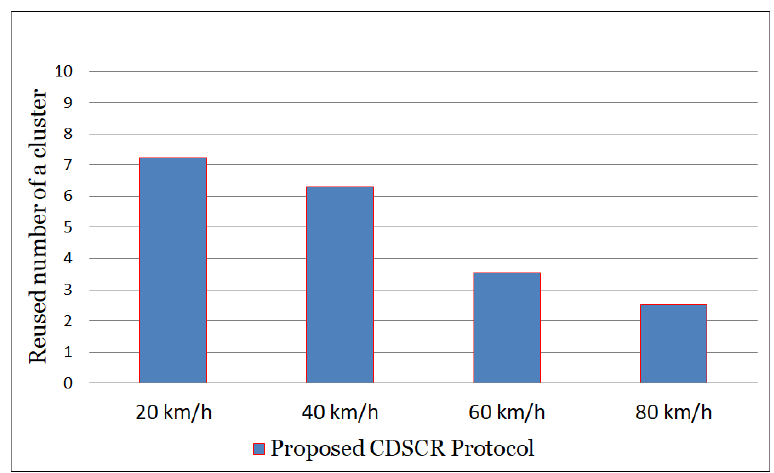
Figure 8. Reused number of a cluster versus node